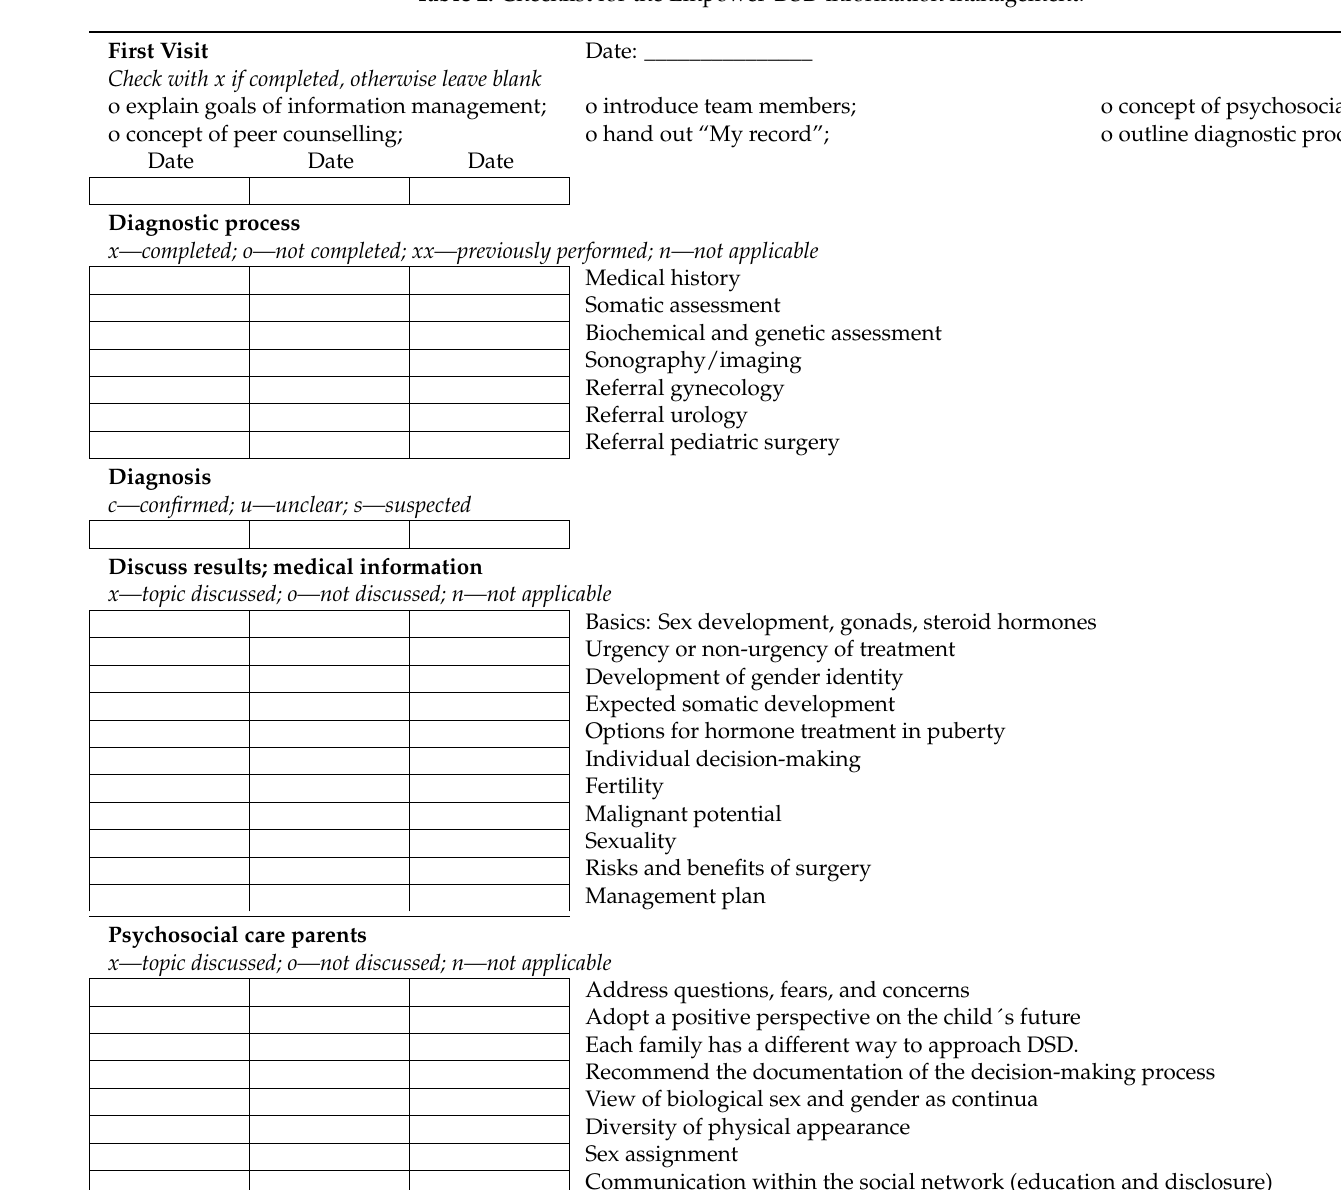
Table 2. Checklist for the Empower-DSD information